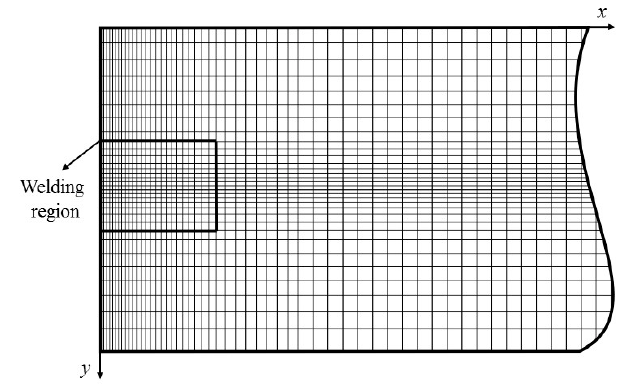
Figure 2. Non-uniform Cartesian mesh applied in simulation (air view).